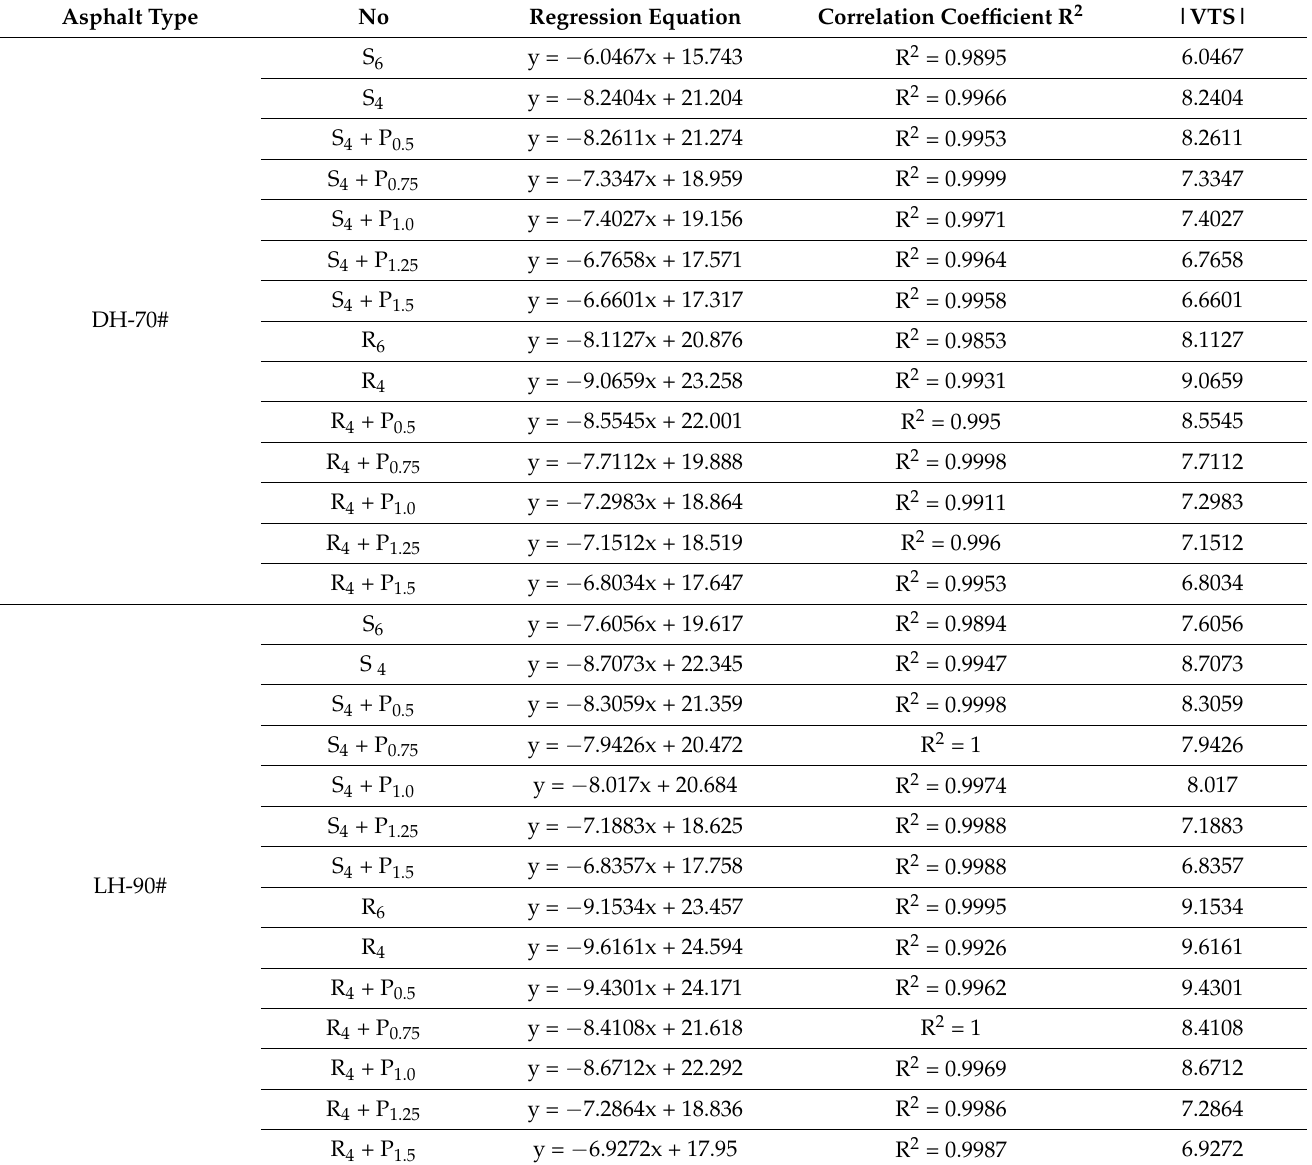
Table 5. Double logarithm regression results of different asphalt